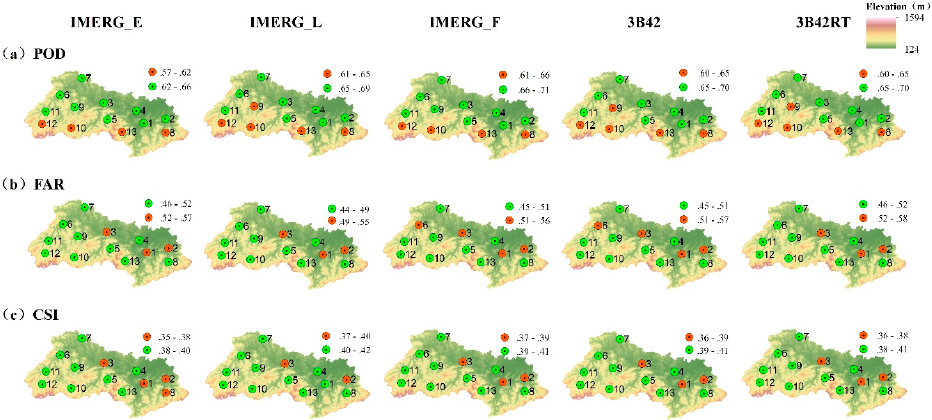
Figure A7. Spatial distribution of the categorical evaluation metrics (April to October) at hourly scale: ( a ) POD ; ( b ) FAR ; and ( c ) CSI .